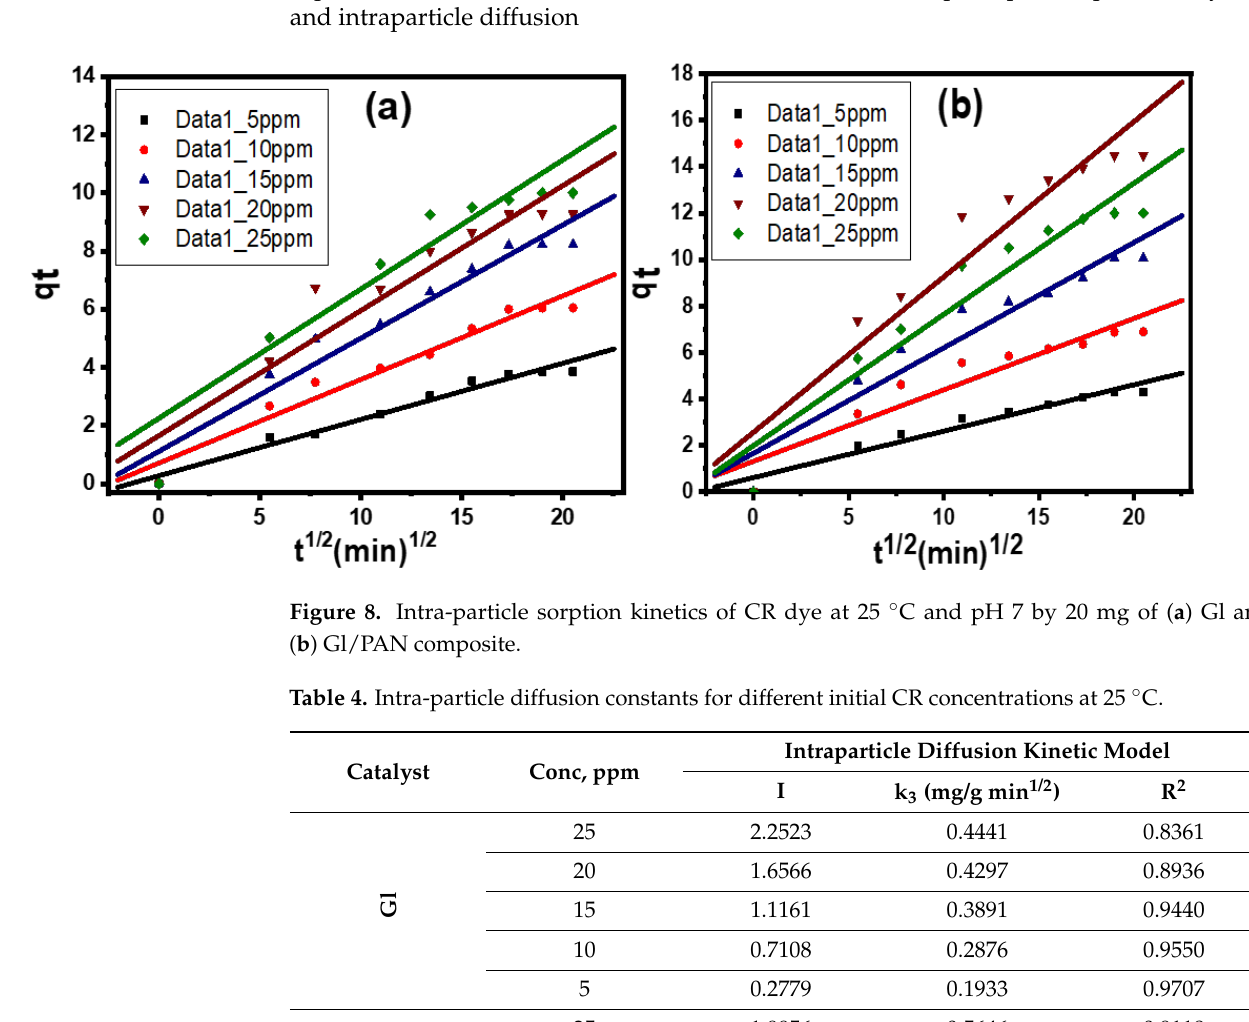
Table 5. Comparison of the optimized conditions, removal%, and adsorption capacity of different CR adsorbents relative to Gl and GL/PAN adsorbents.